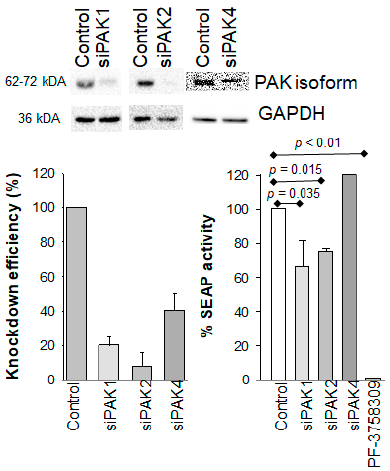
Figure 2. RNA expression levels of different PAK isoforms in 24ST1NLESG cells ( a ) and in purified naïve (T N ) and central memory (T CM ) CD4+ T cells. PAK RNA expression is reported relative to cellular IPO8 expression. Data in Figure 2a represent the mean from two independent experiments. Data in ( b ) are from a single RNAseq experiment.